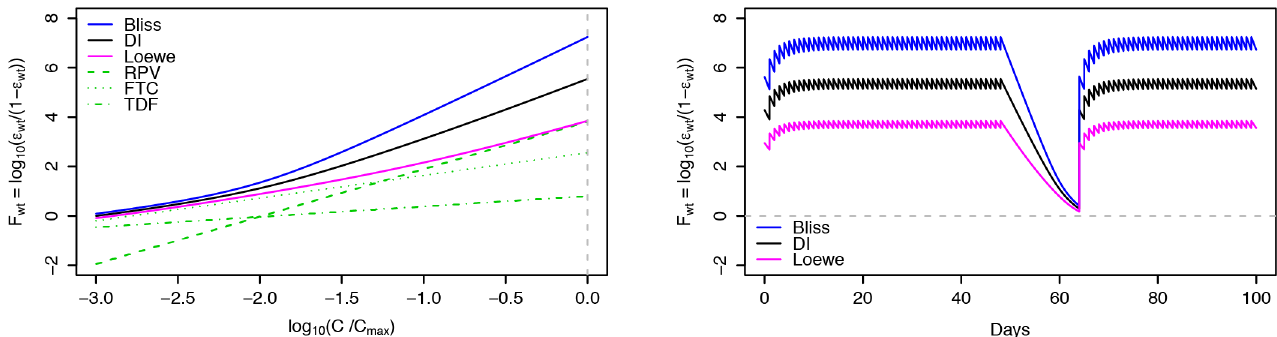
Fig 6. Drug inhibition as a function of drug concentration and time. Left: Logarithmic measure of inhibition (F wt ) as a function of drug concentration (percentage of maximum concentration, log 10 -scale), for drugs RPV, FTC and TDF alone (green lines) and predictions of the combined effect of RPV+FTC +TDF by the Bliss, Loewe and DI model. For the DI model, a hypothetical index 0.5 of degree of independence was assumed. The vertical grey dashed line represents the inhibition potential at maximum concentration for all three drugs. Right: Logarithmic measure of inhibition (F wt ) as a function of days, based on the Bliss, Loewe and DI model combined effect predictions. Simulations are representative of triple combination ART initiation with RPV+FTC+TDF, for a patient 100% adherent to therapy, except for a treatment interruption of 15 days, starting at day 50. After 15 days, a level of only 50% inhibition, represented by the horizontal grey dashed line, starts being